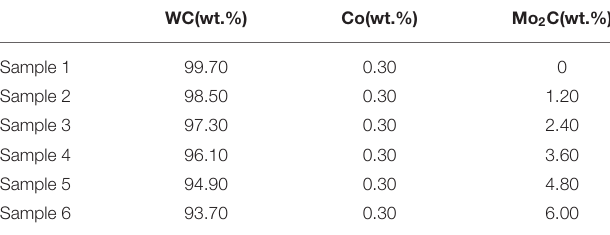
TABLE 1 | Compositions of WC-0.3Co-xMo 2 C